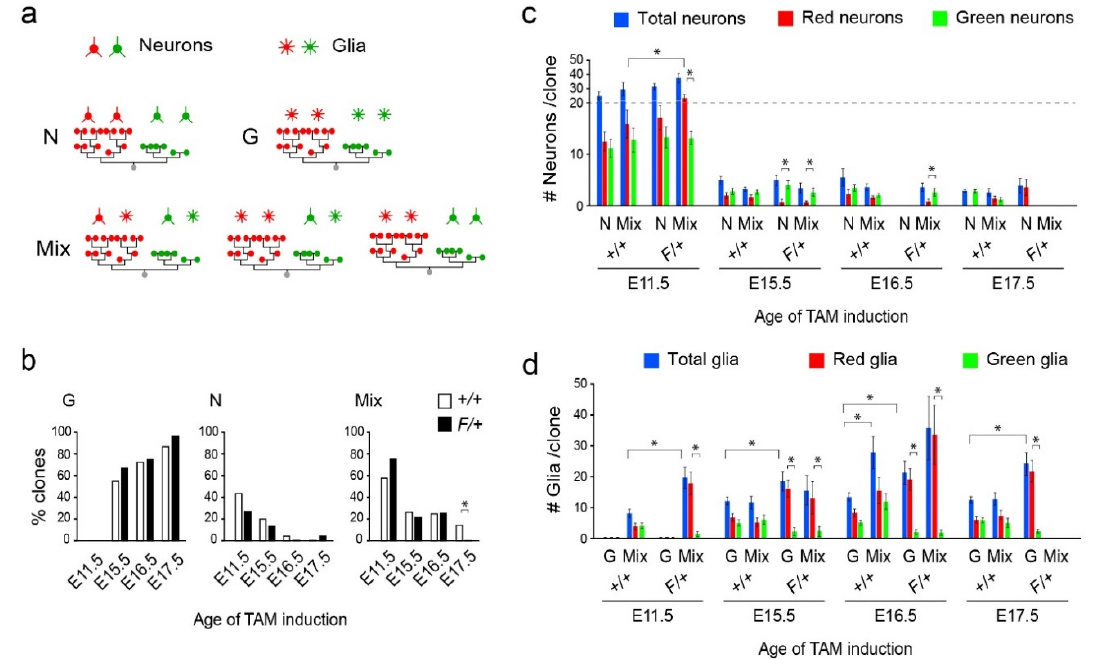
Figure 3. Analysis of MADM clone types. ( a ) Classification of clones based on their neuronal and glial compositions. ( b ) Percentage of all clones containing G, N or Mix types across the different induction time points and genotypes (green and red MADM cells are combined). ( c ) Numbers of neurons in different clone types in +/+ and F/+ cortices at different induction times. Total numbers of neurons are broken down into their green and red sibling fractions as shown. The scales for Y -axis values are not the same for the 0–20 and 20–50 ranges in order to reveal the low values for neurons in E15.5–E17.5 induced clones. ( d ) Numbers of glia in different clone types in +/+ and F/+ cortices at different induction times. Total numbers of glia per clone are broken down into their green and red sibling fractions as shown. Data are mean ± sem. *, rank-sum test, p < 0.05.